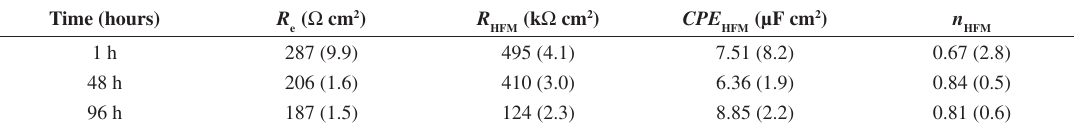
Figure 8. Equivalent circuit (a) samples F1P60D (at all times studied) and F1P90D (only up to 1 hour); (b) samples F1P60M and F1P90M (at 96 hours of immersion). Table 5. Electrical elements fitted values for F1P60M film up to 96 h of immersion in 0.05 M NaCl solution. The error % associated with each parameter value is given in parenthesis.